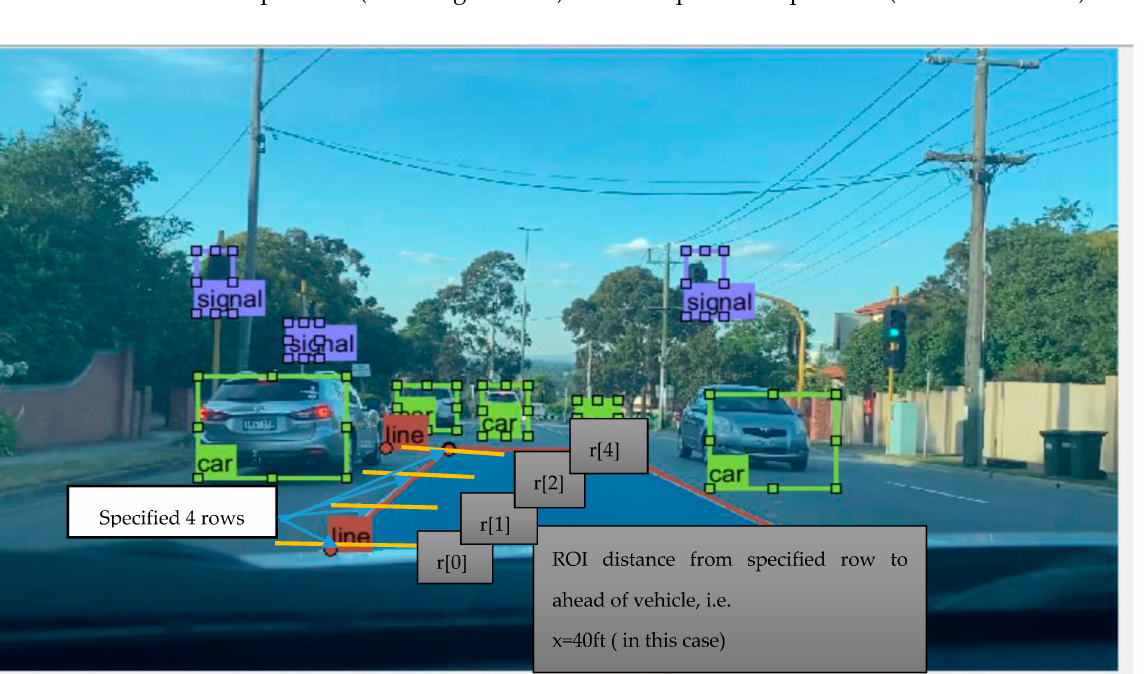
Figure 3. Defining a finite number of rows (four rows in this case) in the image.